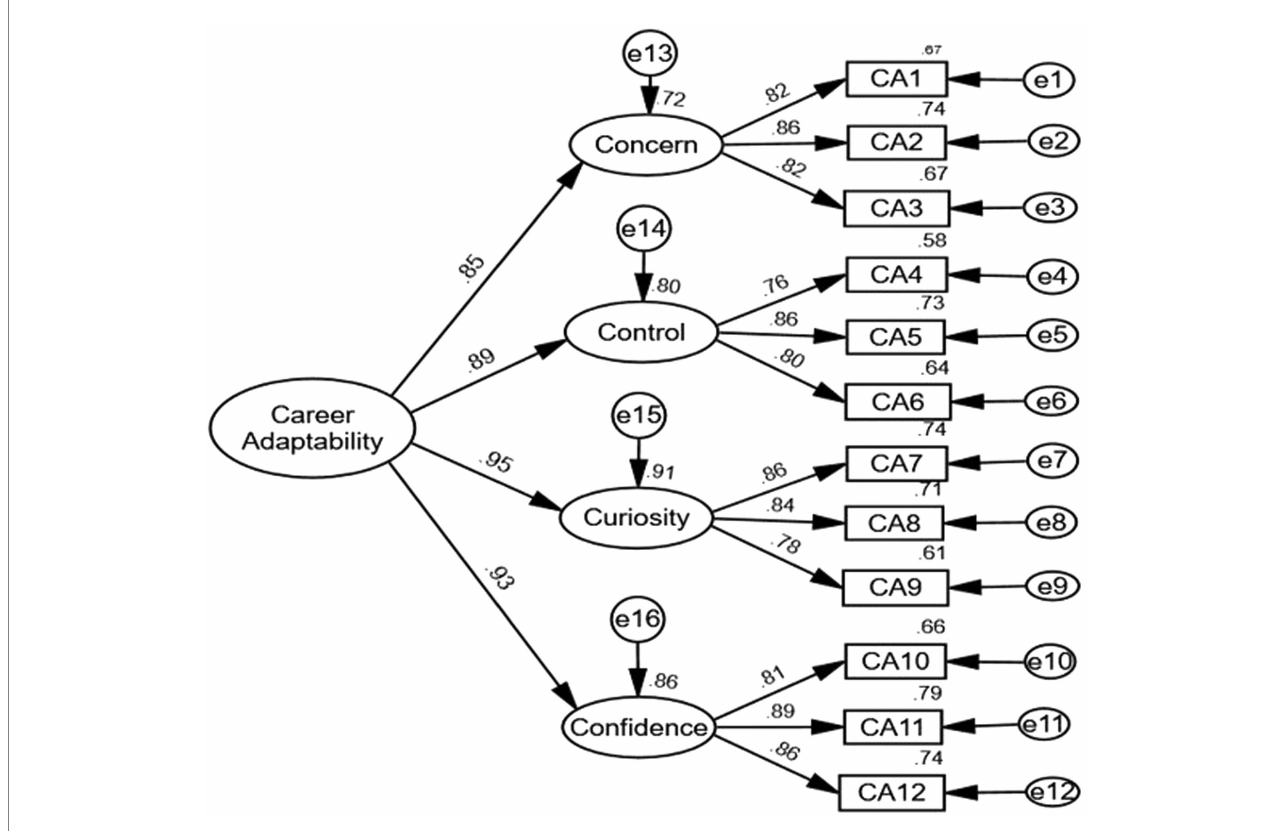
FIGURE 1 Confirmatory Factor Analysis of Career Adapt-Abilities Scale–Short Form China. Note. N = 571. Standardized regression coefficients are shown. Source: Collated through this